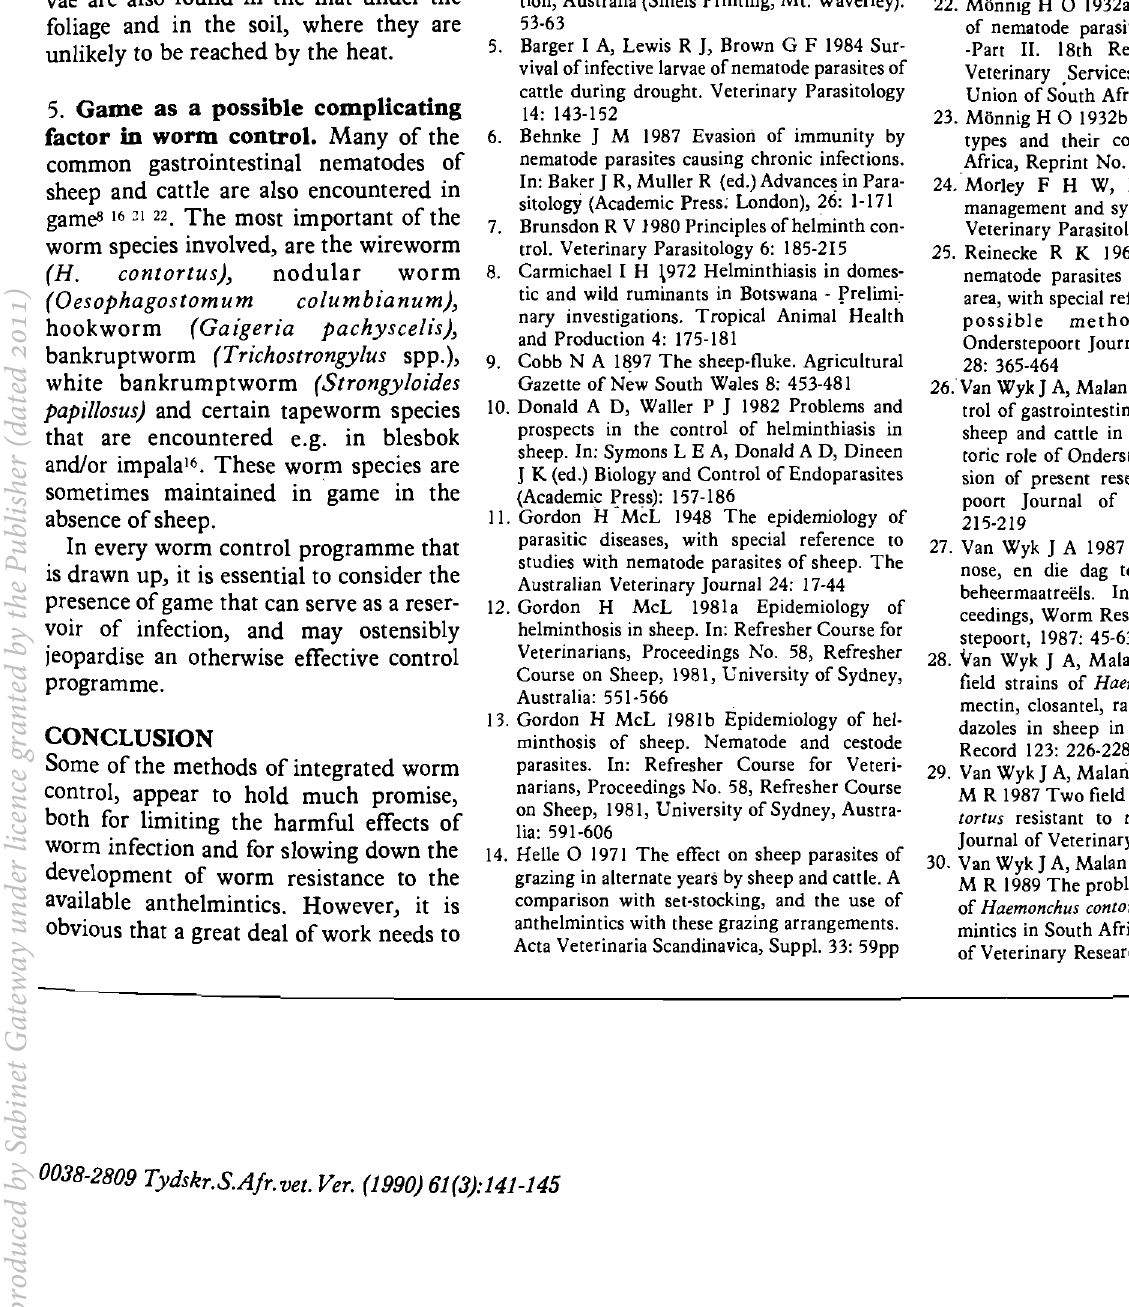
methods of prophylaxis. Onderstepoort Journal of Veterinary